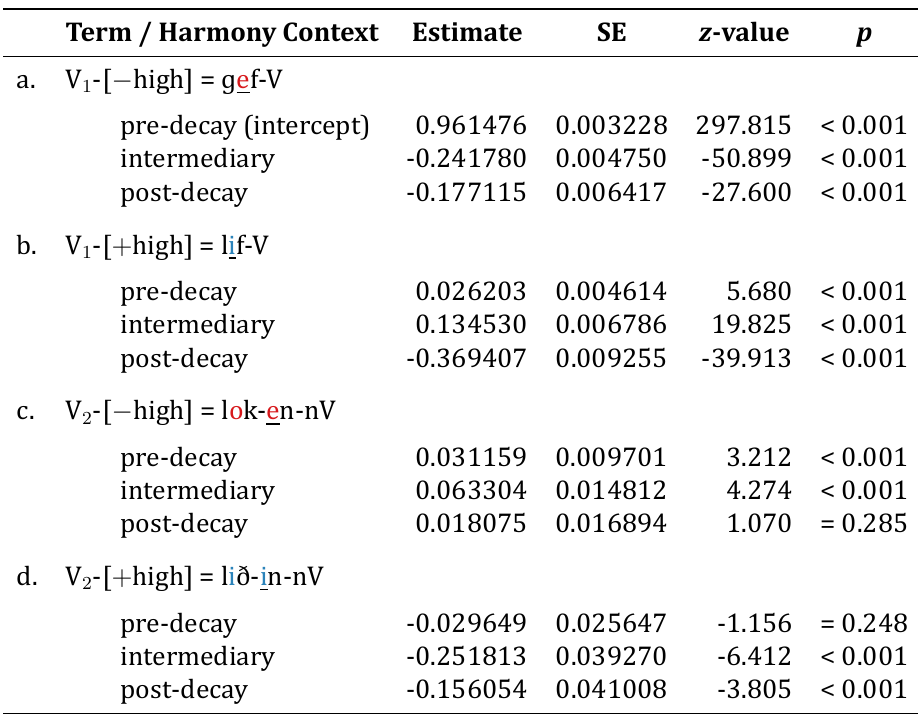
Table 4: Result summary: coef(cid:976)icient estimates, standard errors, z -scores, and signi(cid:976)icance level p for all predictors in the analysis monise in /lif-i/ ‘live’-(cid:277)(cid:279)(cid:266)(cid:280).3.(cid:280)(cid:268).(cid:280)(cid:282)(cid:263)(cid:271). than in /ɡef-i/-type contexts. While levelling suf(cid:976)ixes as high [-i, -u] generally boosts harmony levels in high vowel contexts like lif-V, harmony is actually signi(cid:976)icantly less likely in tri- syllabic positions following non-initial V -[ + high] vowels in both inter- 2 mediary ( E = − 0 . 252 , z (45334) = − 6 . 41 , p < 0 . 001 ) and